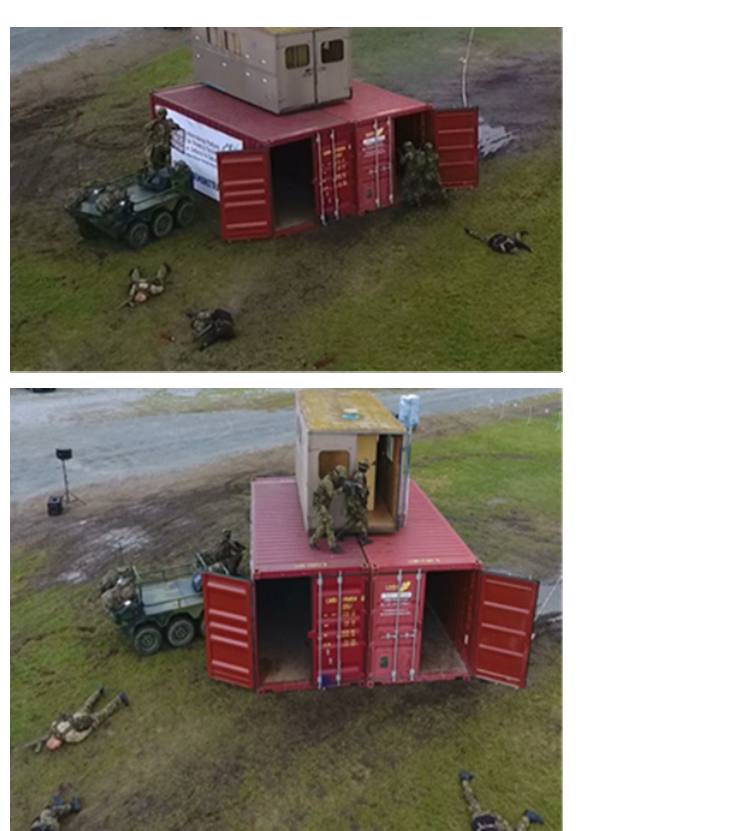
Figure 5 – Use of the TAROS during the execution phase. The image taken by the drone controlled by the team